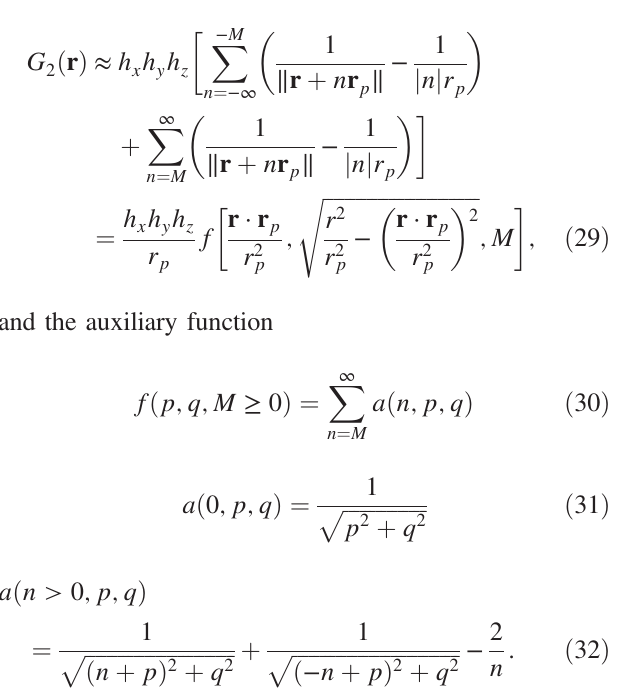
Fig. 4. The highest values of Δ f appear at q ≃ 0 .